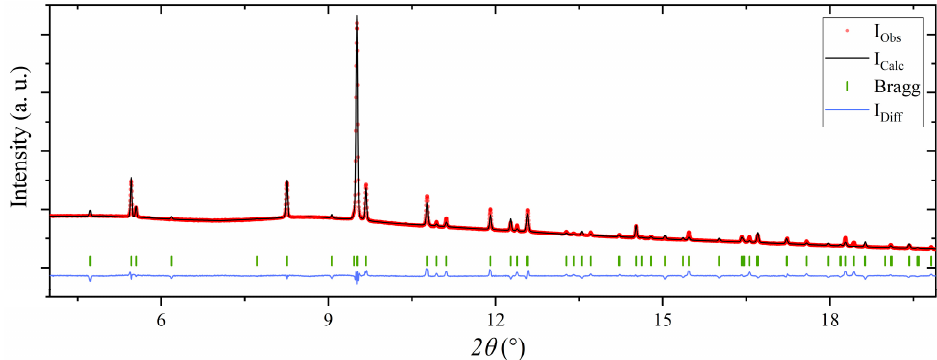
Figure 3. Rietveld refinement of the structural model of Mg(BH 4 ) 2 ∙ (CH 3 ) 2 CHNH 2 in the space group I2 1 2 1 2 1 , using the powder X-ray diffraction pattern of Mg(BH 4 ) 2 ∙ 1.20IPA ( s3 ). R-factors: R p = 1.26, R wp = 2.47, conventional R-factors: R p = 37.6 and R wp = 23.2 and R Bragg =